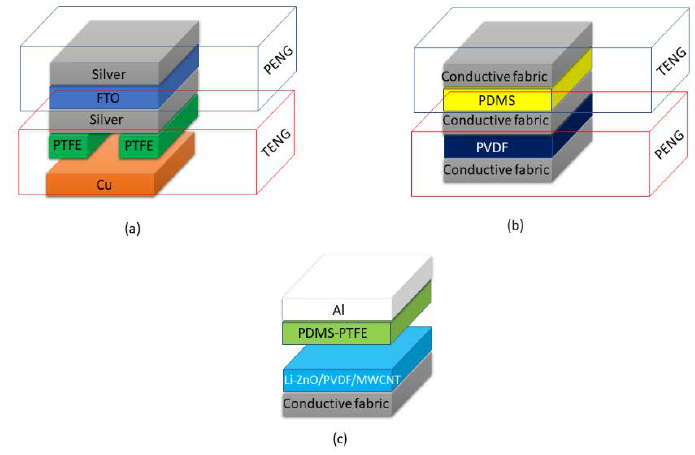
Figure 3. Schematic view of hybrid devices integrating triboelectricity and piezoelectricity with separated (TENG–PENG) configuration (a) Ref. [85] and (b) Ref. [97] or mixed configuration (c) Ref. [94]. PENG: piezoelectric nanogenerators.